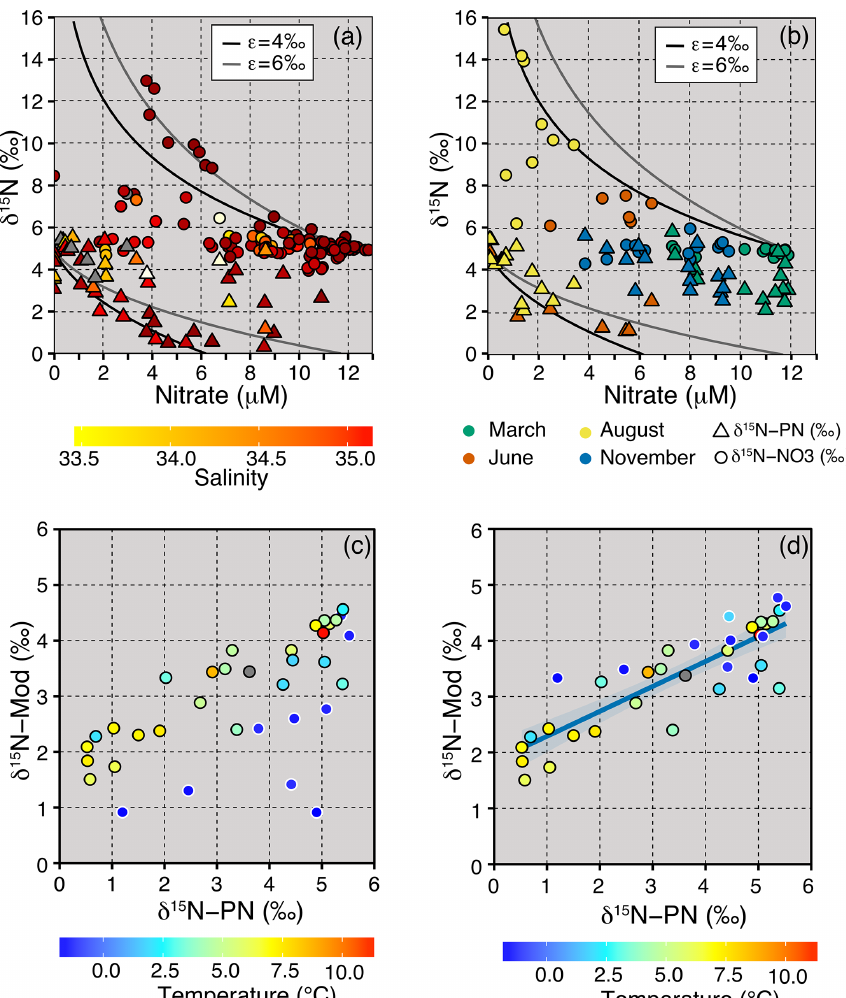
Figure 6. (a) δ 15 N-NO 3 (circles, upper 150m) and δ 15 N-PN (triangles, upper 50m) plotted against nitrate (JR16006), with the colour axis denoting changes in salinity. The lines show the fractionation models for a closed system at ε = 4 and 6‰ with an initial nitrate concentration of 11.8µM and δ 15 N-NO 3 of 5.1‰. (b) Surface measurements of δ 15 N-NO 3 (circles) and δ 15 N-PN (triangles) plotted against nitrate from the March, June, August and November Norbjørn transects, with the colour denoting the month of sampling. The lines show the fractionation models for a closed system at ε = 4‰ and 6‰. (c) Regression between measured and predicted δ 15 N-PN in the upper 40m (euphotic zone) using a 4.8‰ fractionation for all samples. (d) Regression between measured and predicted δ 15 N-PN in the upper 40m (euphotic zone) using a 4.8‰ fractionation for AW and a 1.8‰ fractionation for ArW ( r = 0.86, df = 33, p = 0). ArW samples in (c) and (d) are outlined in